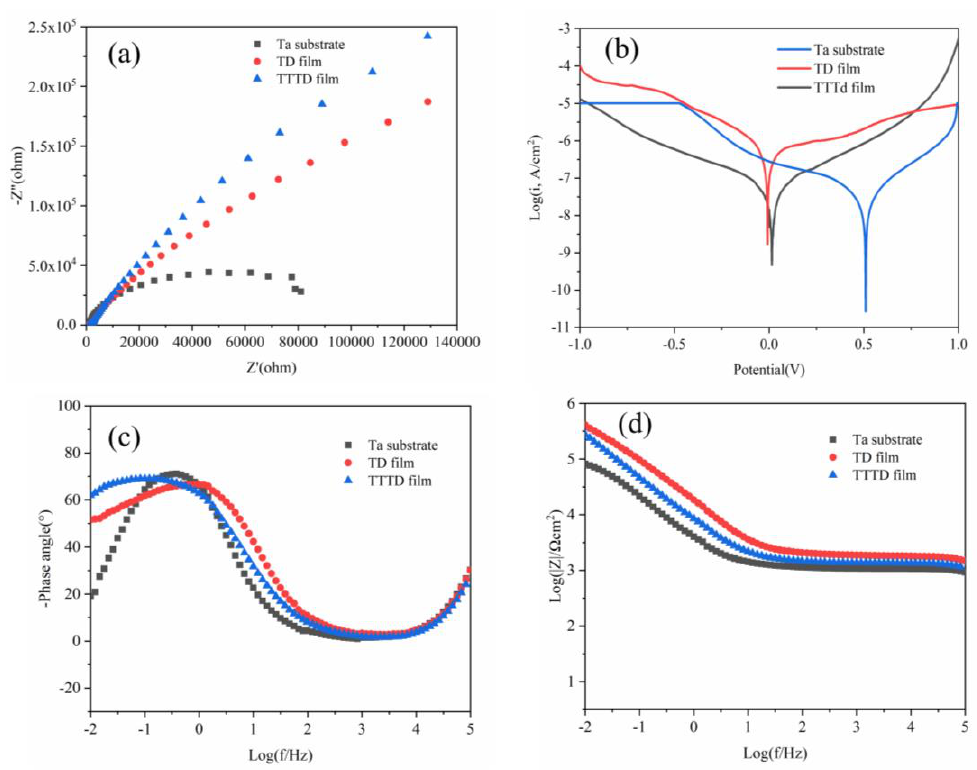
Figure 10. Corrosion test of Ta substrate, TD film, and TTTD film in weak acid environment: ( a ) Nyquist curve, ( b ) polarization curve, ( c ) phase angle diagram, ( d ) impedance value.